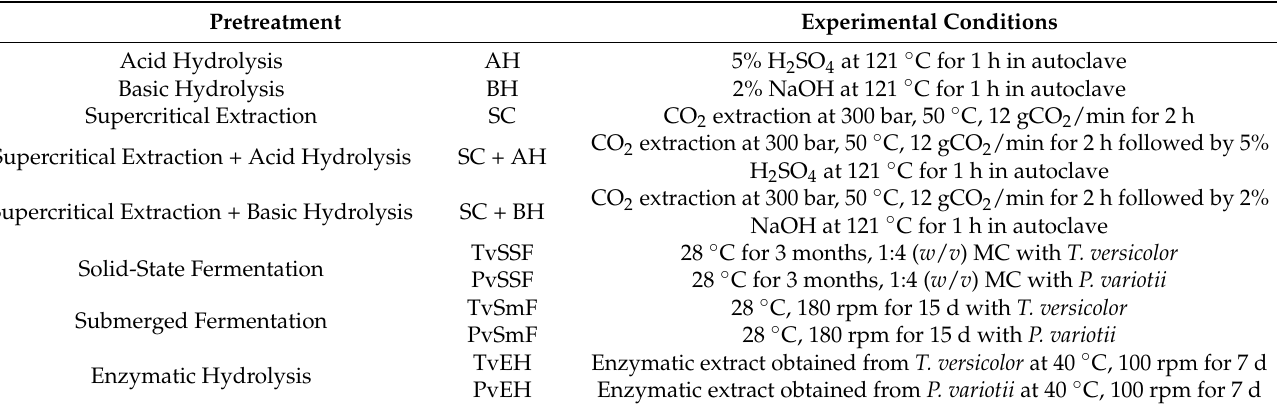
Table 1. Overview of the pretreatments and respective